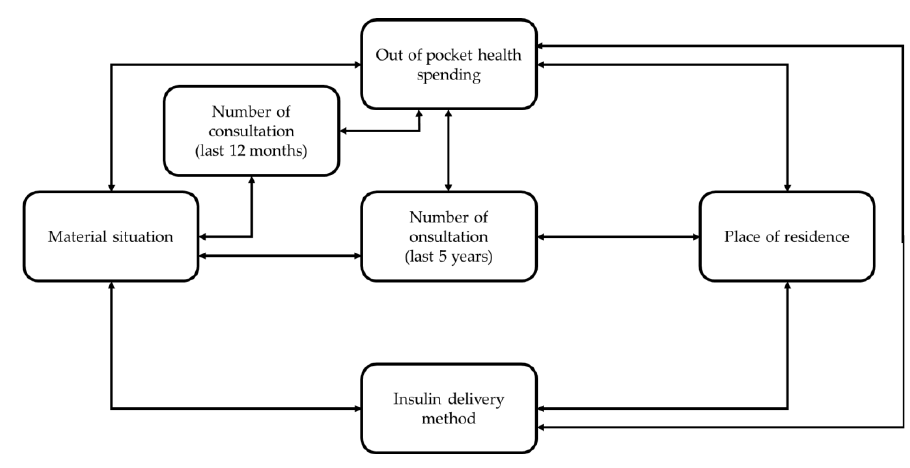
Figure 2. Strongest correlations